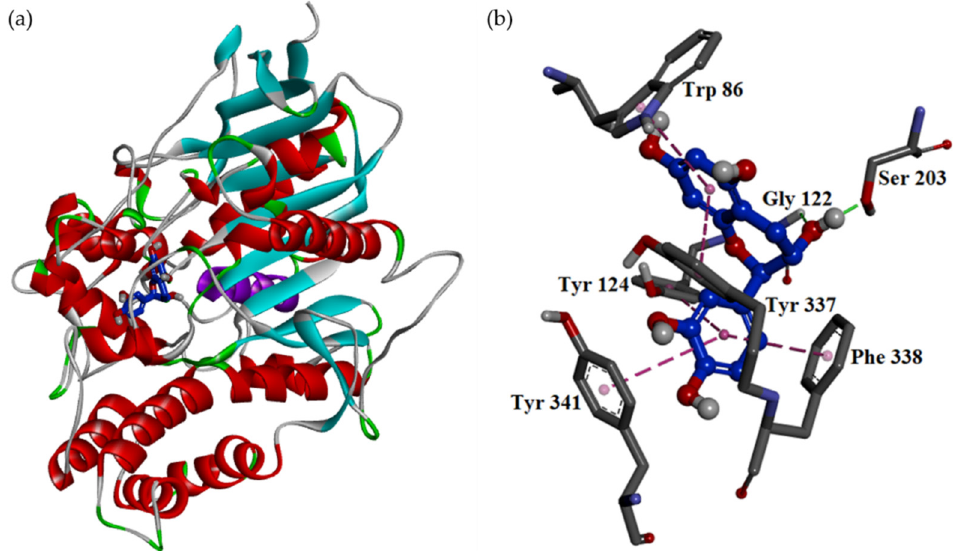
Figure 3. Interaction of catechin ( 1 ) with the active sites of acetylcholinesterase from Electrophorus electricus . The binding mode ( a ) and the hydrophilic interactive model ( b ) of catechin ( 1 ) in the substrate binding pocket of the crystal structure (PDB: 1C2B).